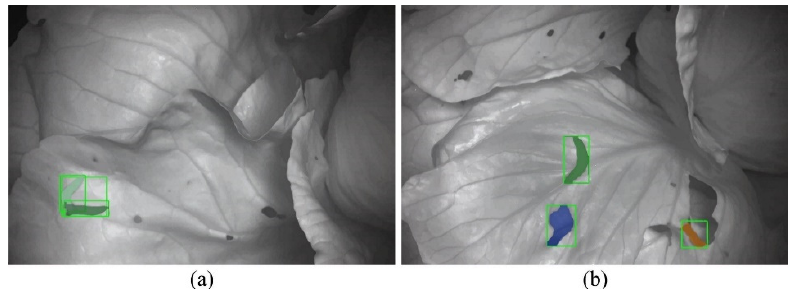
Figure 17. False identification results. ( a ) Two P. rapae larvae overlap each other and ( b ) leaf holes mistakenly identified as P. rapae